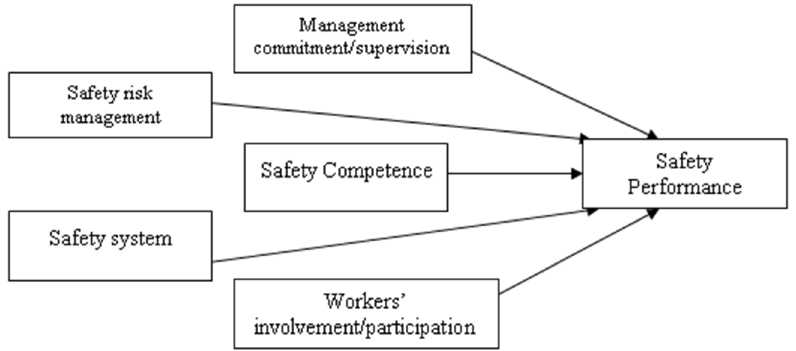
Figure 1. Safety performance model based on safety culture factors.